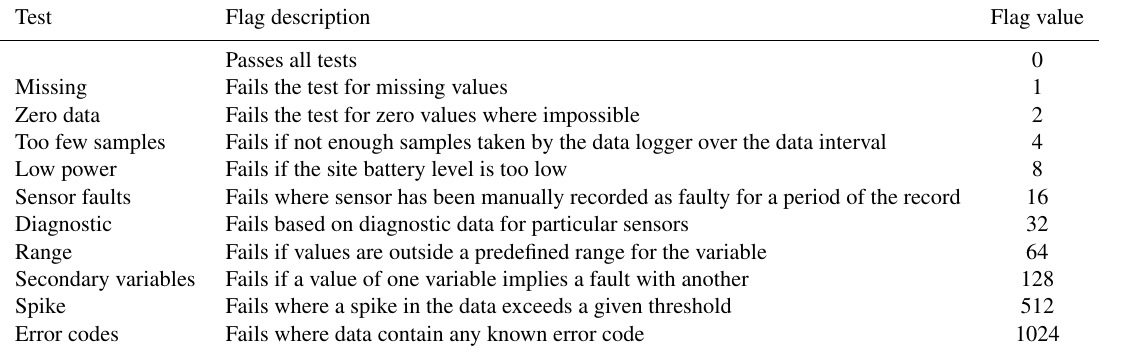
Table 6. Unique flag values assigned to data based on QC test